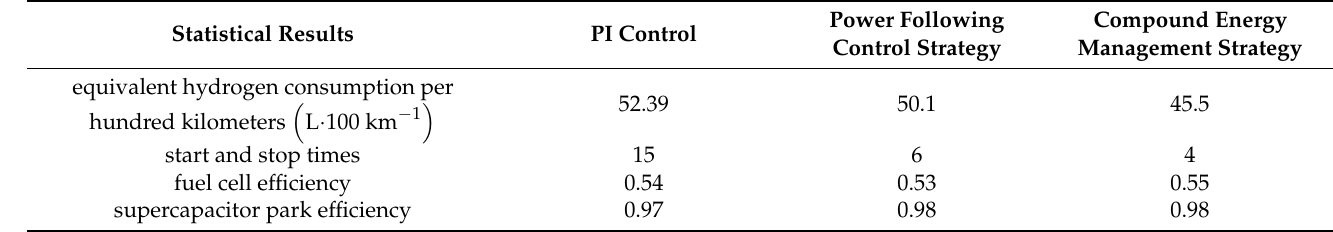
Figure 10. Output power comparison between PI control, power following and compound energy management. Table 3. Comparison of simulation results of three energy management